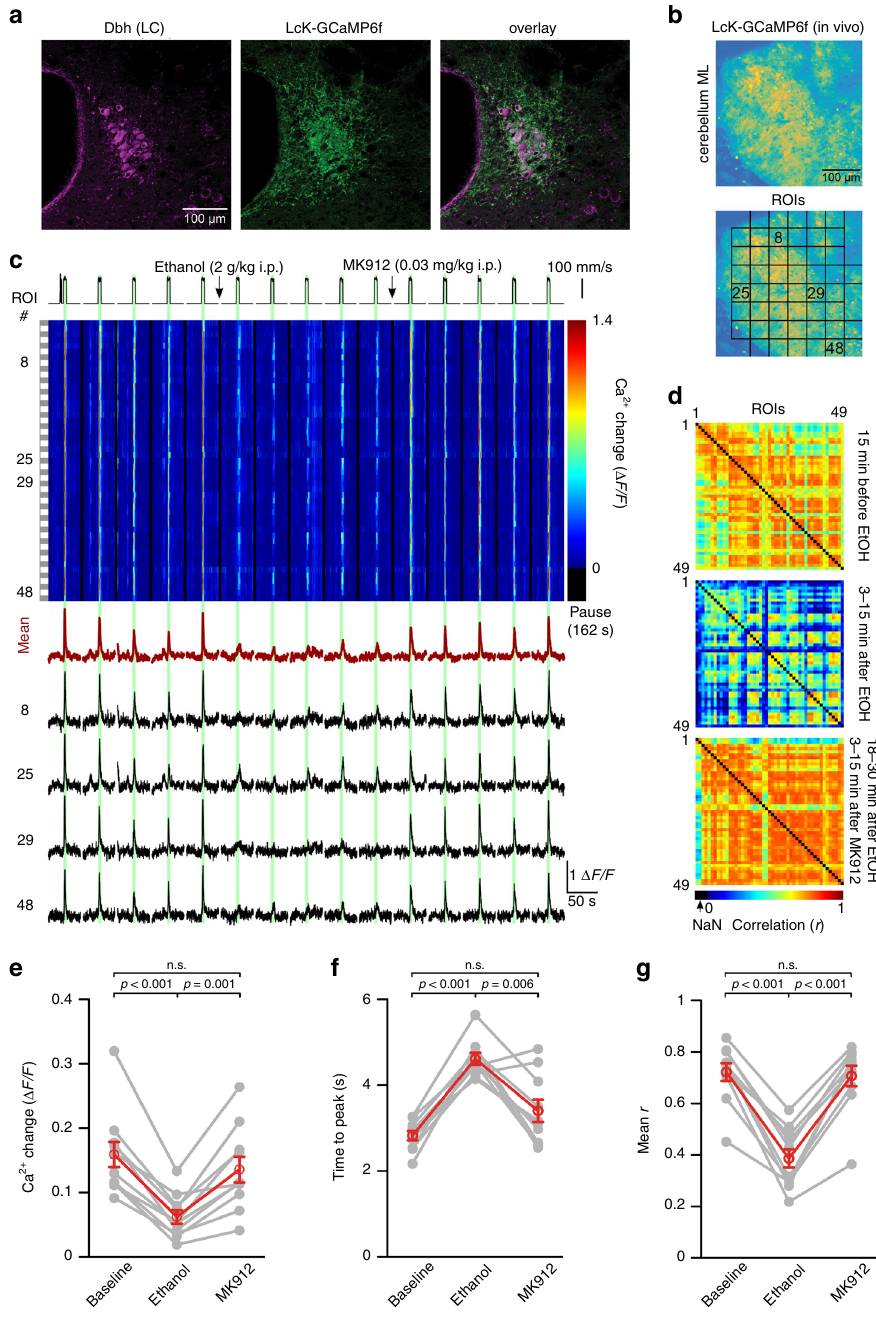
Fig. 8 Ethanol inhibition of vigilance-dependent Ca 2 + elevations in NE terminals accounts for loss of BG Ca 2 + responsiveness. a Confocal image of 6- week-old Dbh-Cre;Lck-GCaMP6f fl ox mouse LC stained for eGFP (Lck-GCaMP6f, green) and dopamine β -hydroxylase (Dbh) (magenta). Three independent experimental repetitions were obtained with similar results. b Upper, In vivo image of Dbh-Cre;Lck-GCaMP6f fl ox mouse cerebellar molecular layer. Lower, Locations of ROIs. Nineteen independent experimental repetitions were obtained with similar results. c Upper, Pseudocolour plot of ROIs ’ Ca 2 + dynamics. Green bars, enforced locomotion. Lower, Average Ca 2 + response of all ROIs (dark red) and Ca 2 + response traces within number-de fi ned ROIs. d Respective pairwise linear Pearson correlation coef fi cient plots between individual ROIs ’ Ca 2 + change traces during indicated experimental episodes. e – g Population data representing mean Δ F / F 10s ( e ), mean time to peak ( f ), and mean correlation coef fi cient ( r ) ( g ) among Δ F / F traces of individual ROIs. Red symbols, mean ± SEM. Lines between dots support readability. n = 10 mice; repeated measures ANOVA ( e F (2, 18) = 29.575; f F (2, 18) = 27.698; g F (2, 18) = 49.194) was followed by Tukey – Kramer correction; n.s. not signi fi cant. Source data are provided as a Source Data fi